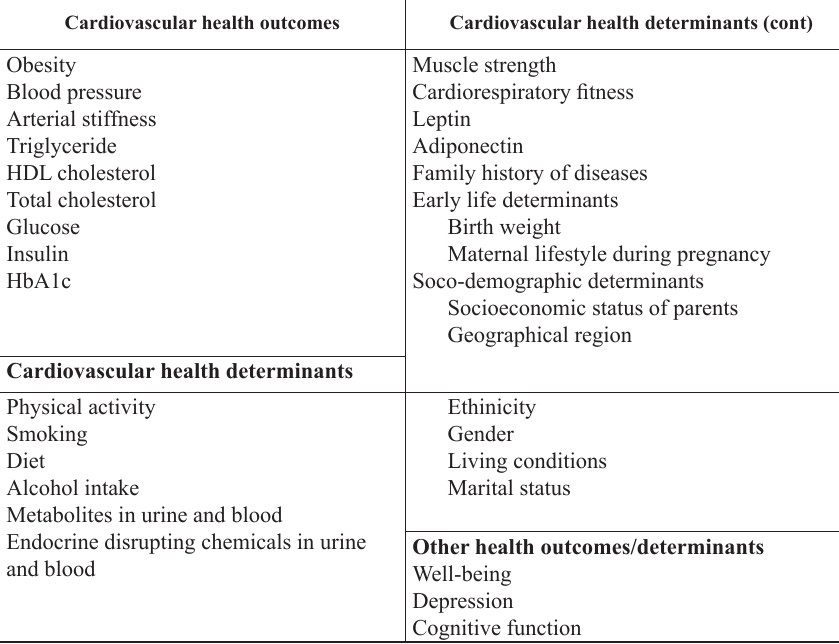
Table. Main cardiovascular outcomes and determinants that have been assessed in the